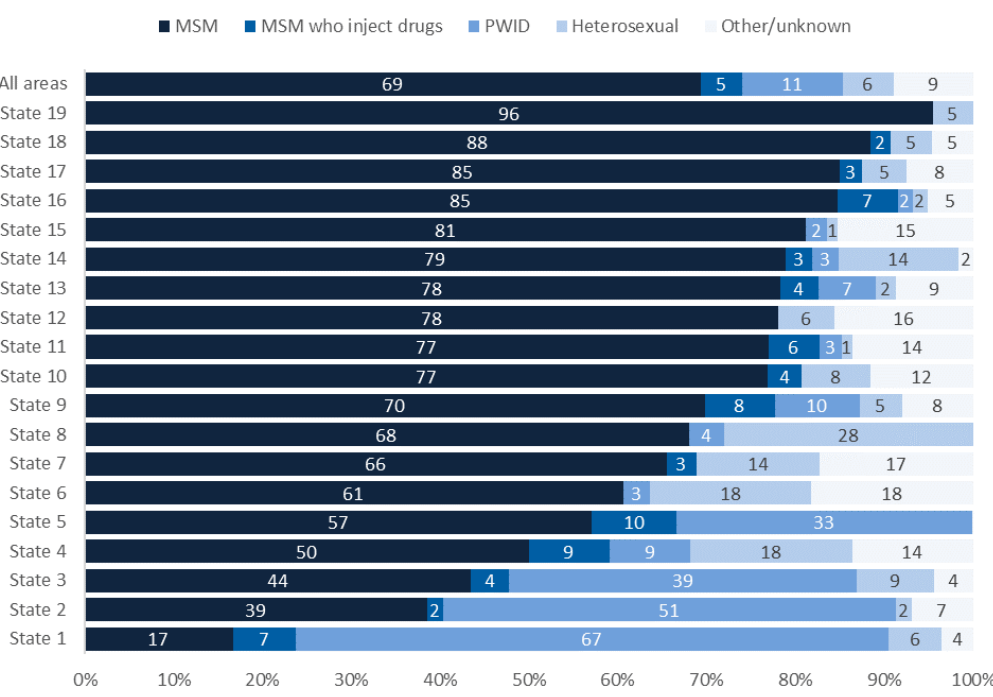
Figure 2. Transmission category of people in clusters of rapid transmission first detected during 2018–2019, overall and in selected states (those with at least 20 cluster members). MSM: men who have sex with men; PWID: people who inject drugs. Table 1. Transmission category and race/ethnicity of people with HIV diagnosed in 2018–2019 and people in molecular HIV clusters first detected in 2018–2019, by state. MSM: men who have sex with men; PWID: people who inject drugs. Only includes states with at least 20 cluster